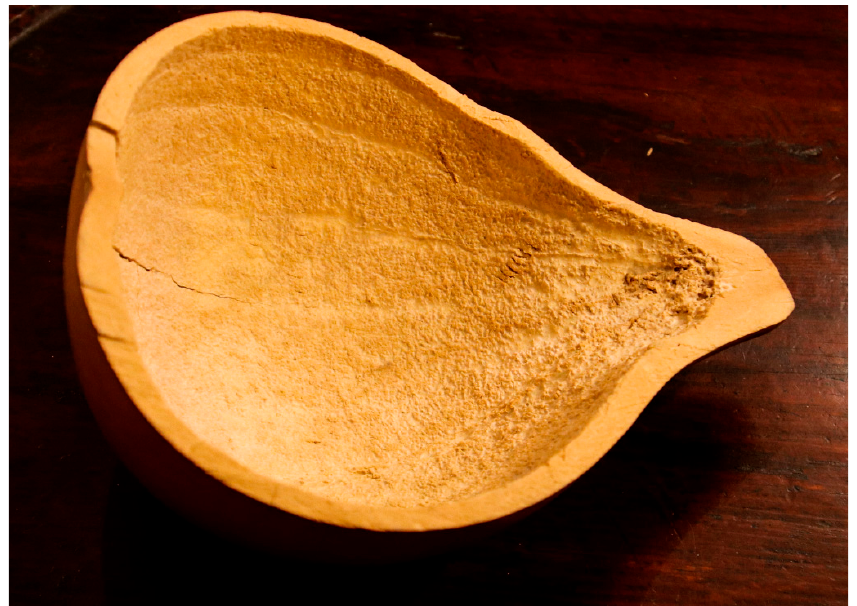
Figure 2. This gourd dipper ( pakaji ) was filled with rice as a fertility charm for the author, 1984). By the 1970s, dippers for domestic use were made of plastic in this shape. Photograph by Homer